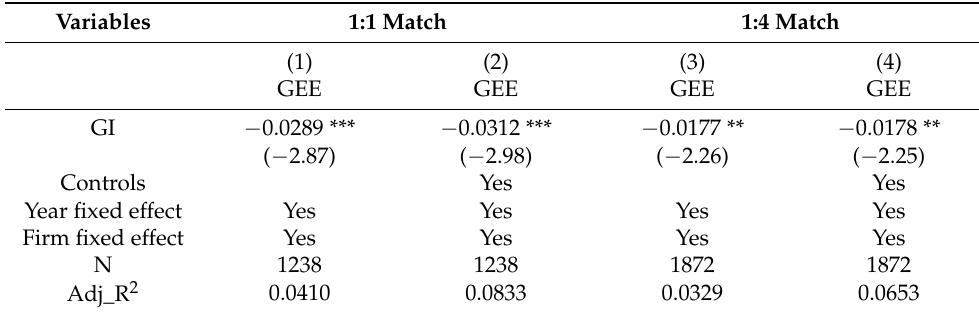
Table 3. Green innovation and green economic efficiency: